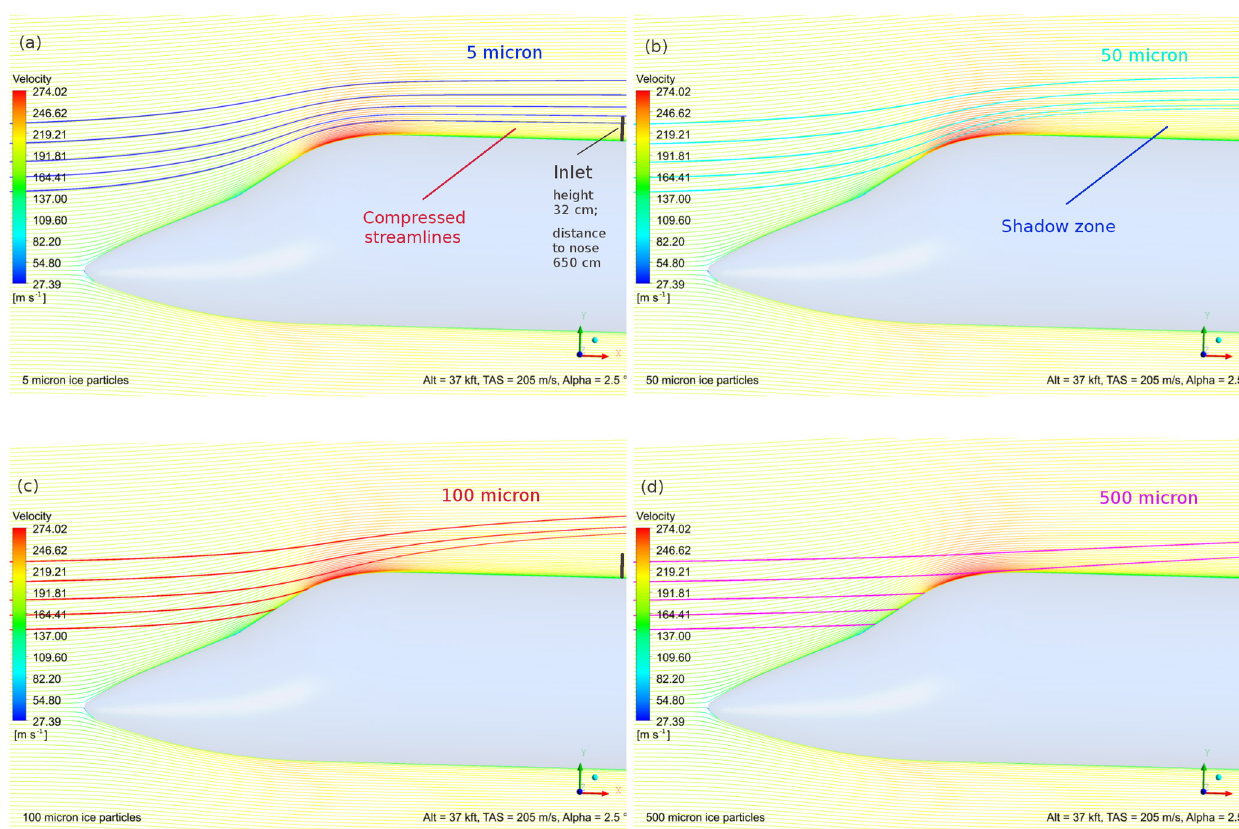
Figure 14. Three-dimensional CFD calculations of gas streamlines (thin lines, color coded by the velocity of the flow) and ice particle trajectories (thick colored lines) around an aircraft with a fuselage similar to the HALO aircraft (note that for legal reasons, the exact envelope of HALO can not be simulated). The IWC inlet is placed on the roof at the same position as the TGI on HALO (see Fig. 4, Sect. 4.1.1). The simulations are run for typical conditions during penetration of cirrus clouds: altitude = 37kft (11.3km), true air speed TAS = 205ms − 1 , angle of attack AOA = 2.5 ◦ and an ice crystal density of 0.918gcm − 3 . The panels are for different particle sizes, indicated in the panels. Ice particles starting at the lowest trajectory position enter the middle inlet tube of the IWC inlet if the particle follows the gas streamline. The simulations are run by means of CFX 18.2 by ANSYS Inc. For a more detailed description of the methods applied to the simulations see Weigel et al.